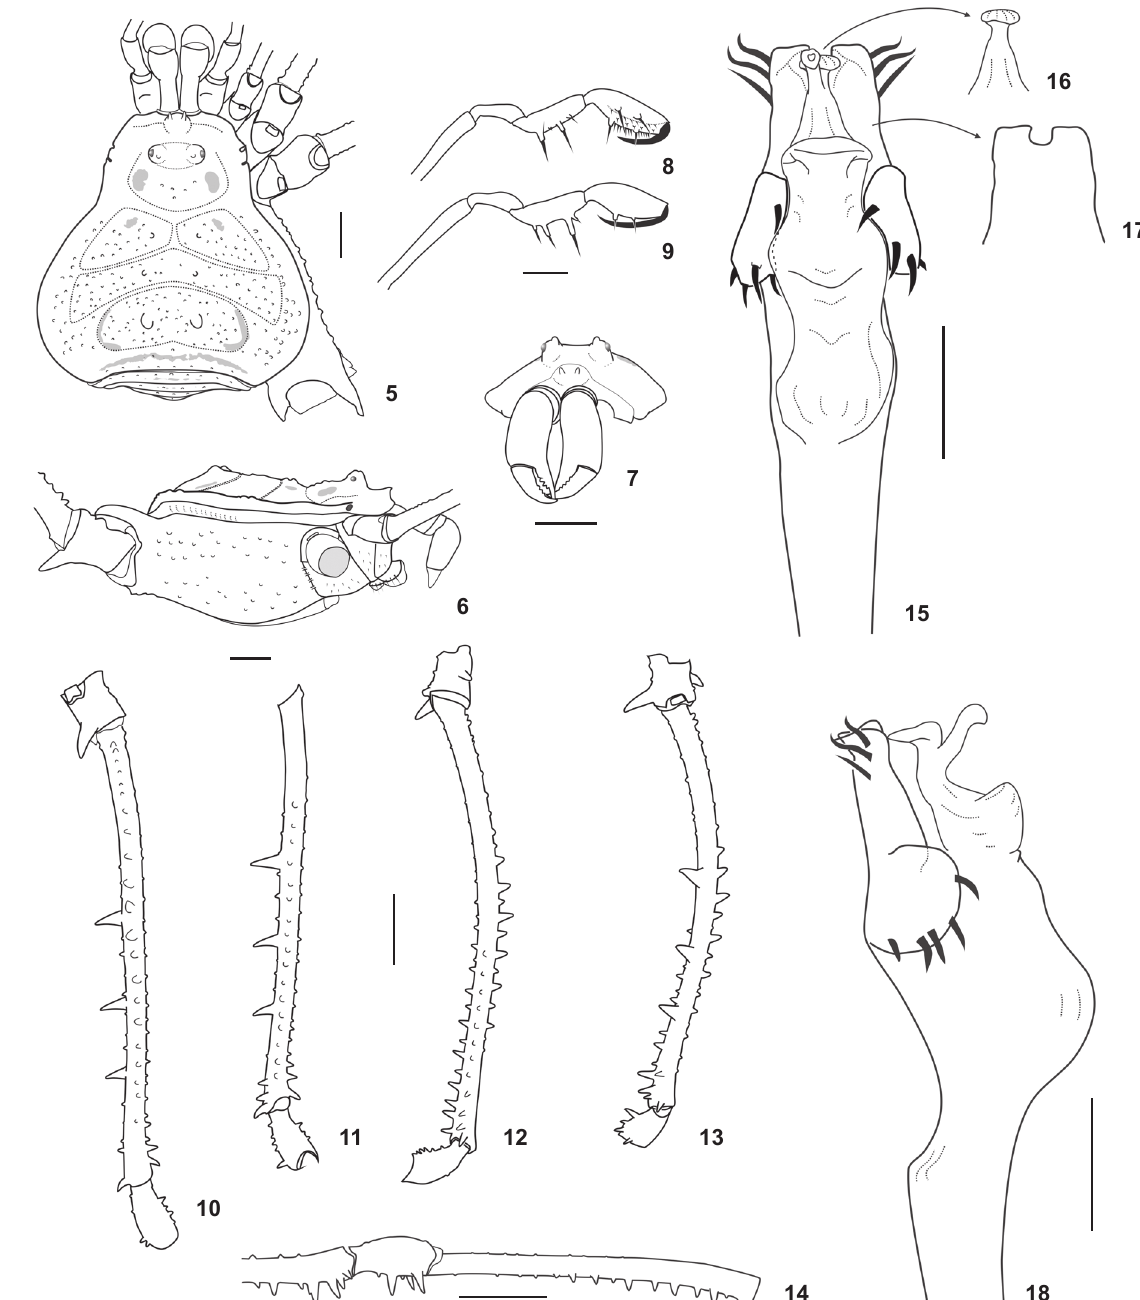
Figures 5-18. Metarthrodes oxum sp. nov. , male holotype: (5) habitus, dorsal view; (6) lateral view; (7) frontal view; (8) left pedipalpus distal femur to tarsus, mesal view; (9) right pedipalpus distal femur to tarsus, ectal view; (10-14) leg IV: (10) trochanter, femur, patella of right leg, dorsal view; (11) femur and patella of left leg, ventral view; (12) trochanter, femur and patella of left leg, prolateral view; (13) trochanter, femur and patella, retrolateral view; (14) apex of femur, patella and tibia of right leg, retrolateral view; (15-18) distal part of penis: (15) dorsal view; (16) detail of ventral process; (17) detail of dorsum of ventral plate; (18) lateral view. Scale bars: 5-9, 15- 18 = 1 mm; 10-14 = 2